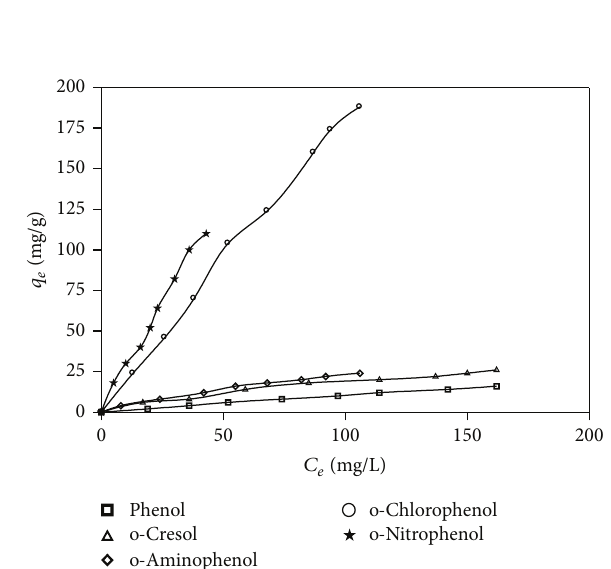
Figure 1: The adsorption isotherms of substituted phenols.